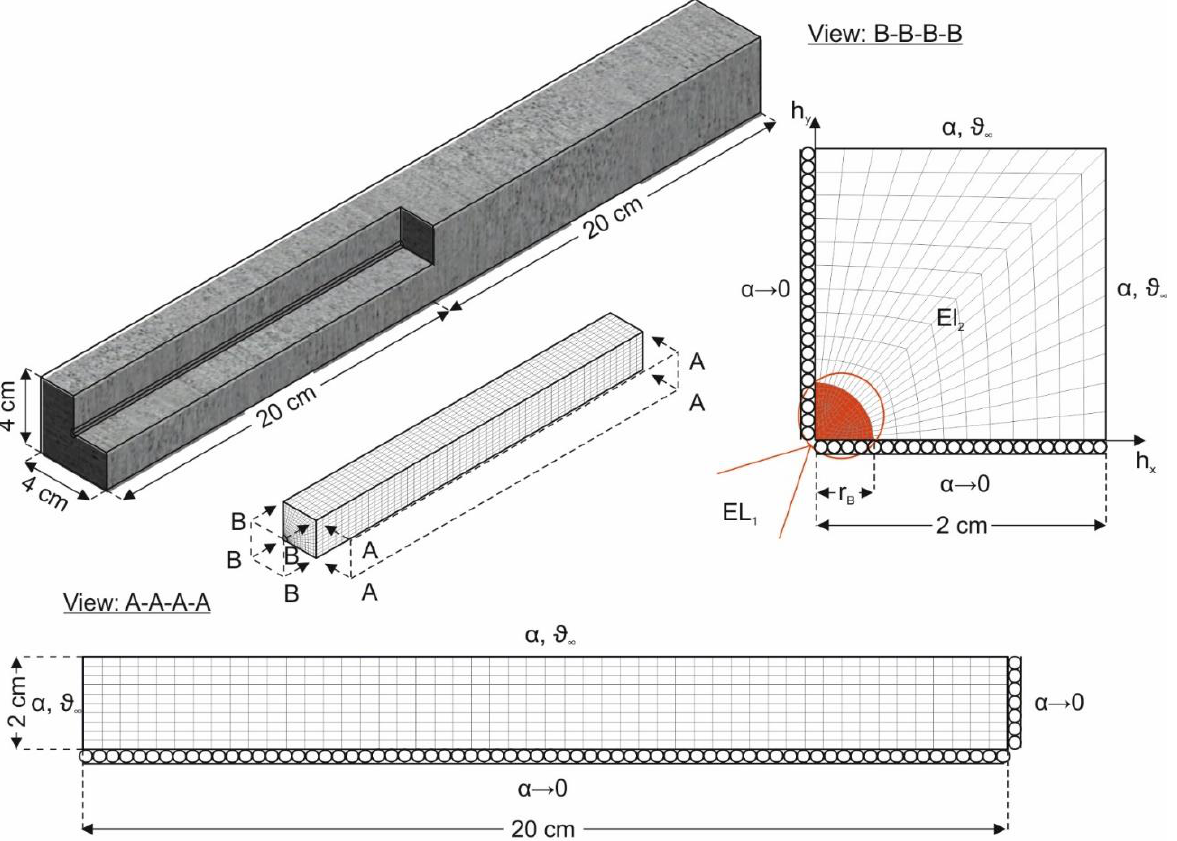
Figure 7. Discretisation of the beams.